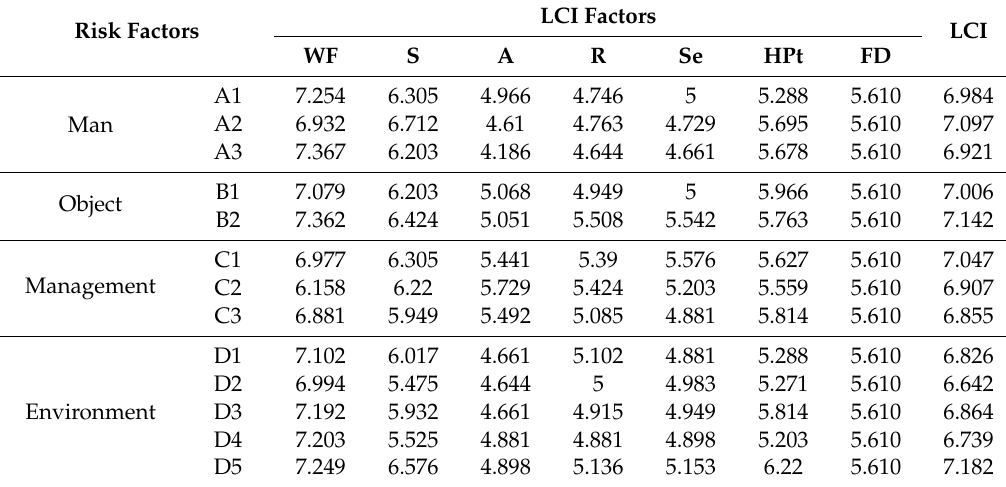
Table 7. LCI factors